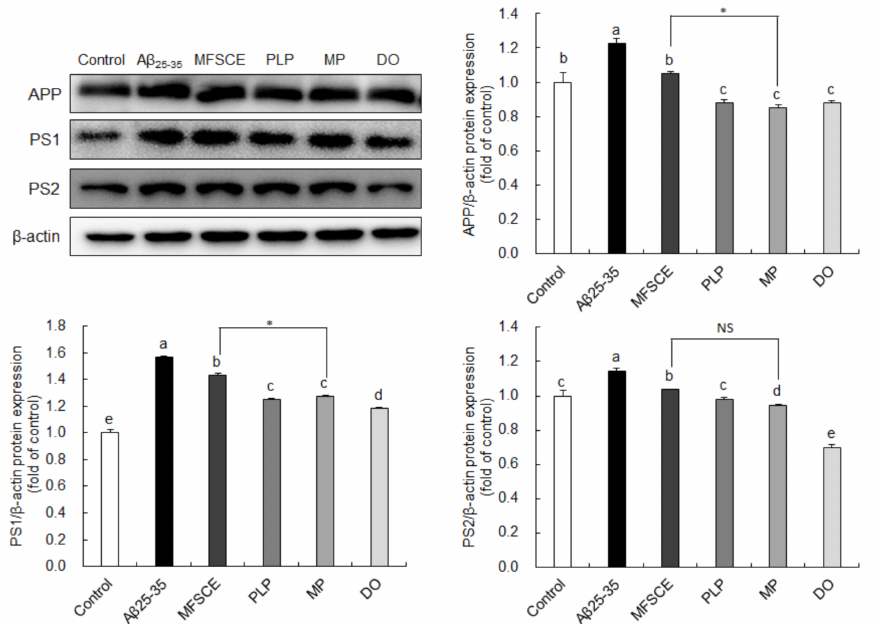
Figure 6. Effect of MFSCE on the amyloidogenic-pathway-related protein expression in the brain of A β 25–35 -injected mice. Western blotting and quantitative analysis of APP, PS1, and PS2 protein expression levels in the brain. Data are expressed as mean ± SD ( n = 3). a–e Means with different letters are significantly different ( p < 0.05) from each group. Asterisk (*) indicates statistically significant differences ( p < 0.05) between MFSCE and MP groups. β -actin served as the loading control. Control group: 0.9% NaCl saline i.c.v. + 0.9% NaCl saline i.p.; A β 25–35 group: A β 25–35 i.c.v. + 0.9%